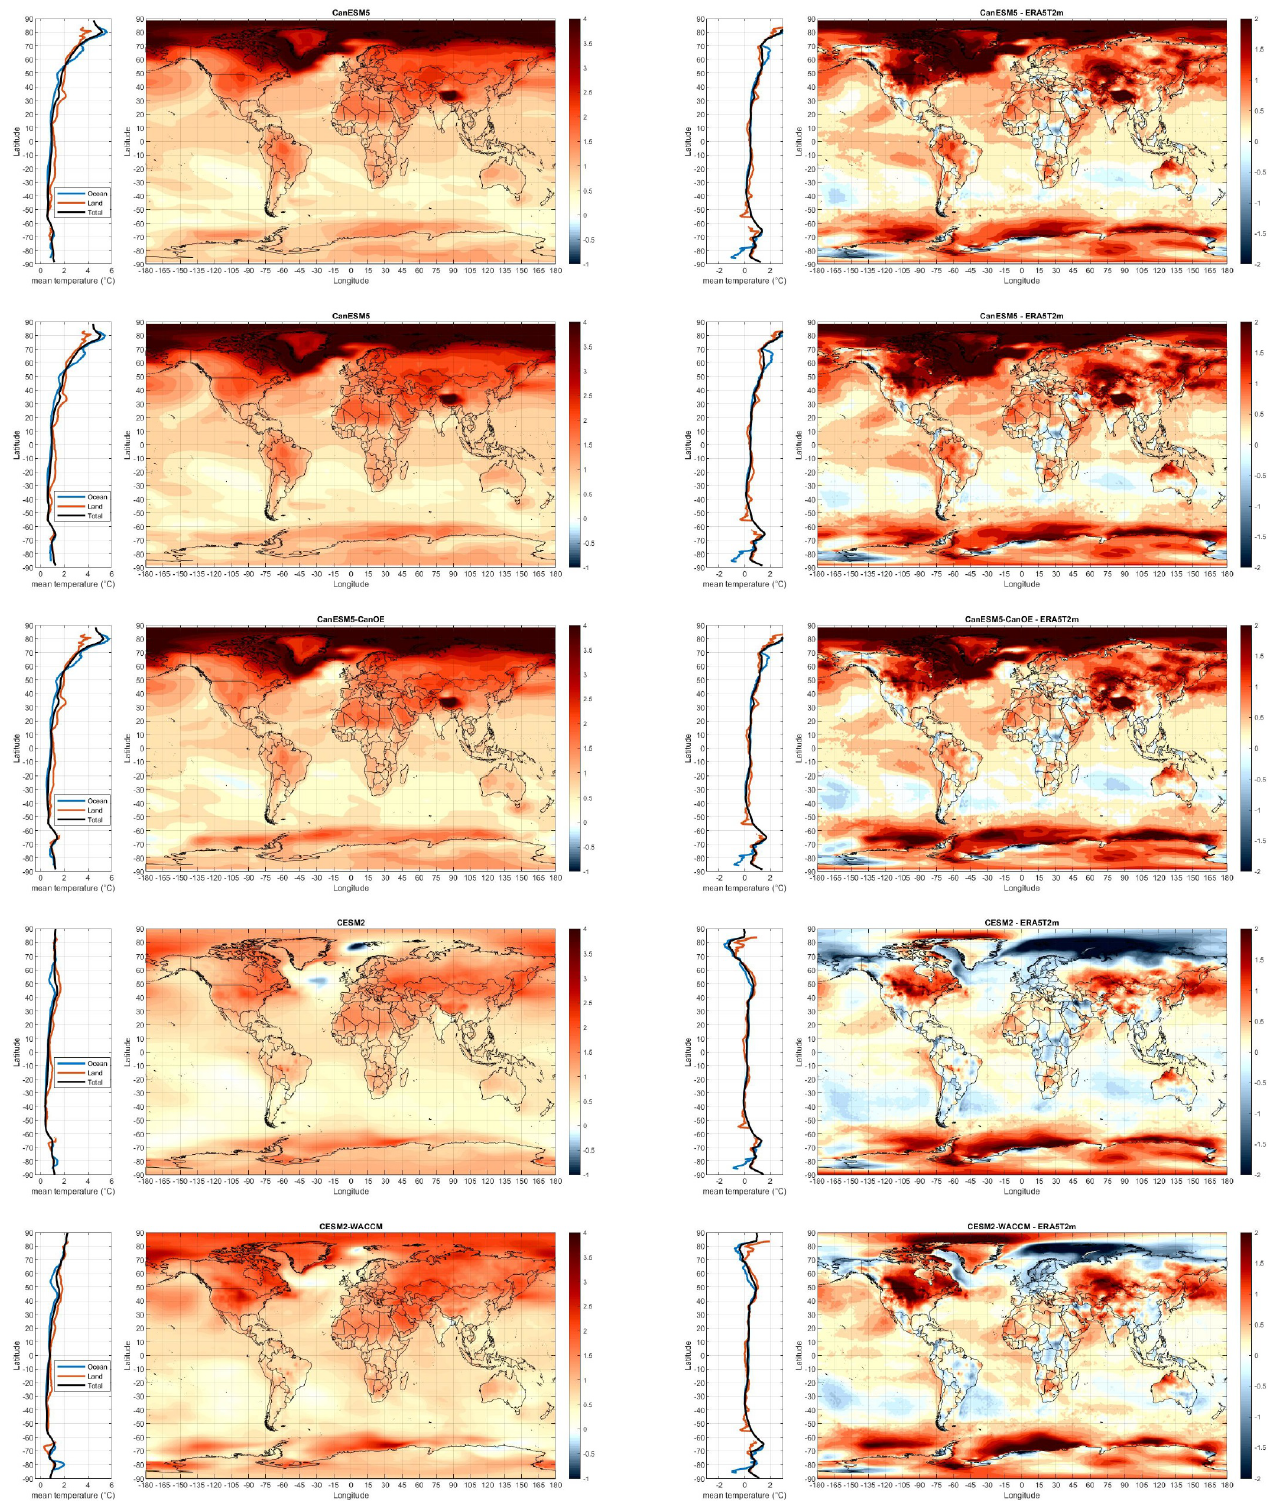
Figure A2. Warming patterns from 1980–1990 to 2011–2021 for the indicated CMIP6-tas GCM ( left ) and its comparison against the ERA5-T2m record ( right